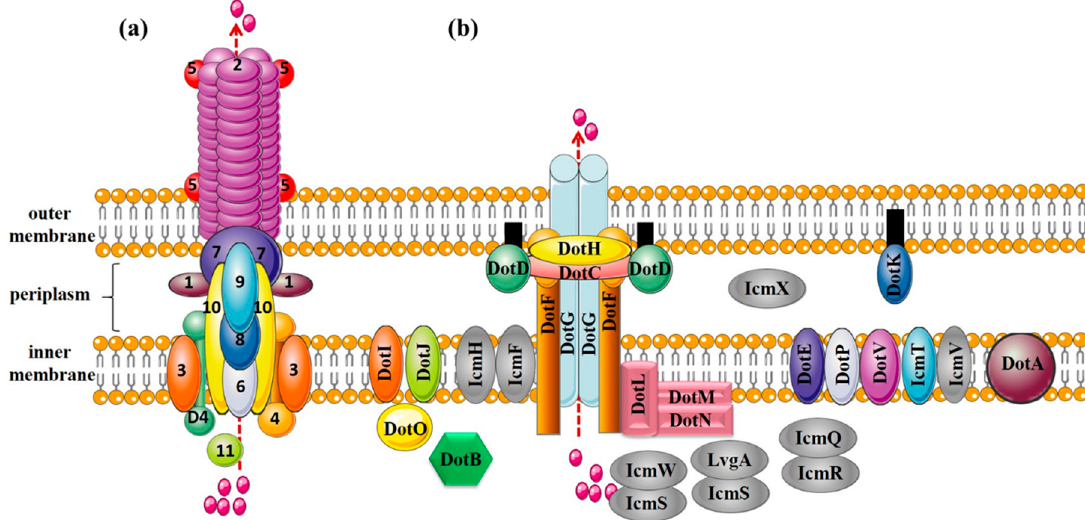
Figure 2. Protein composition of T4ASS (the VirB/VirD4 system from Agrobacterium tumefaciens ) and T4BSS (the Dot/Icm system from Legionella pneumophila ). ( a ) T4ASS. Outer membrane components: VirB7, VirB9, and VirB10; inner membrane components: VirB3, VirB6, and VirB8; pilus components: VirB2 (major pilus component) and VirB5 (minor pilus component); lytic transglycosylase: VirB1; nucleoside triphosphatases: VirB4 and VirB11; coupling protein: VirD4; ( b ) T4BSS. Core complex: DotC-DotD-DotH-DotF-DotG; substrate recognition protein: DotF, DotL, DotM, DotN, IcmSW and IcmS-LvgA; other functional proteins: DotE, DotV, DotP, DotI, DotJ, DotA, DotB, IcmQ, IcmR, IcmF, IcmH, DotK, and DotO; proteins with unknown functions: IcmT, IcmV, IcmX.